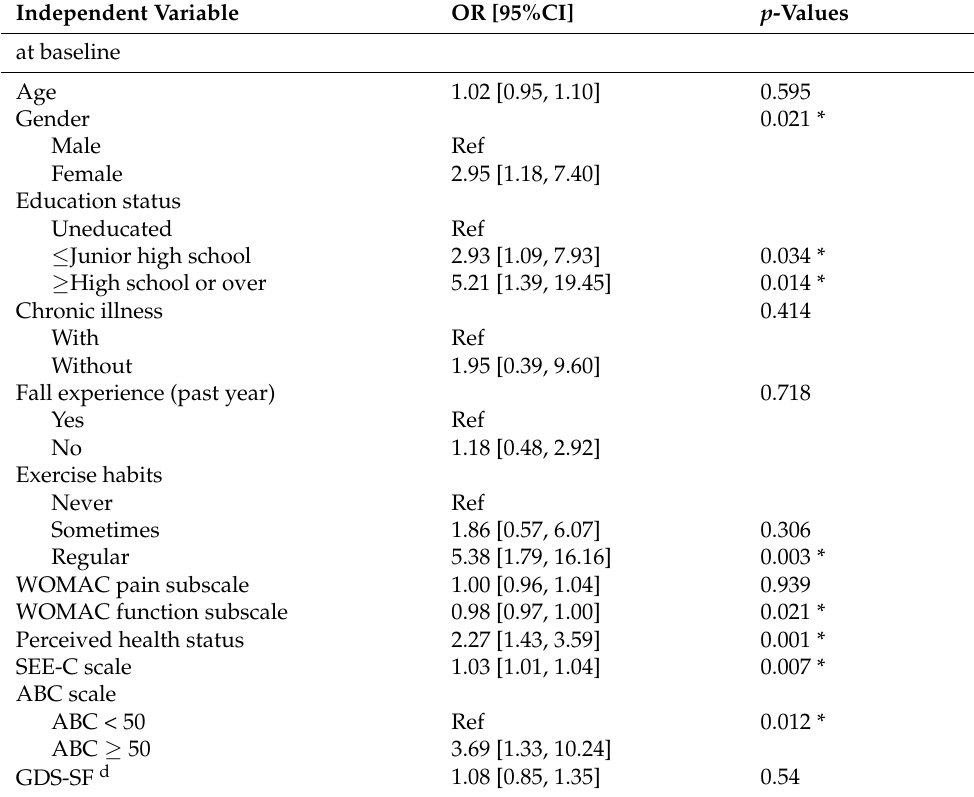
Table 2. Results of multiple logistic regression analysis to predict high OEE.